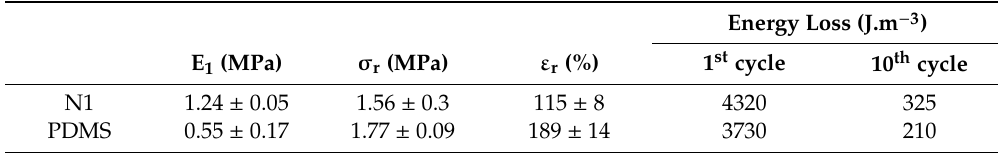
Table 4. Mechanical properties of PDMS and N1 coated